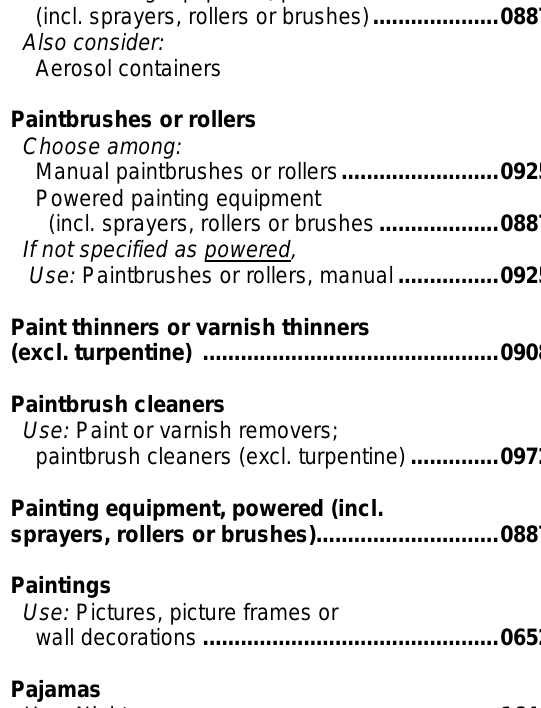
Pads Choose among: Asbestos